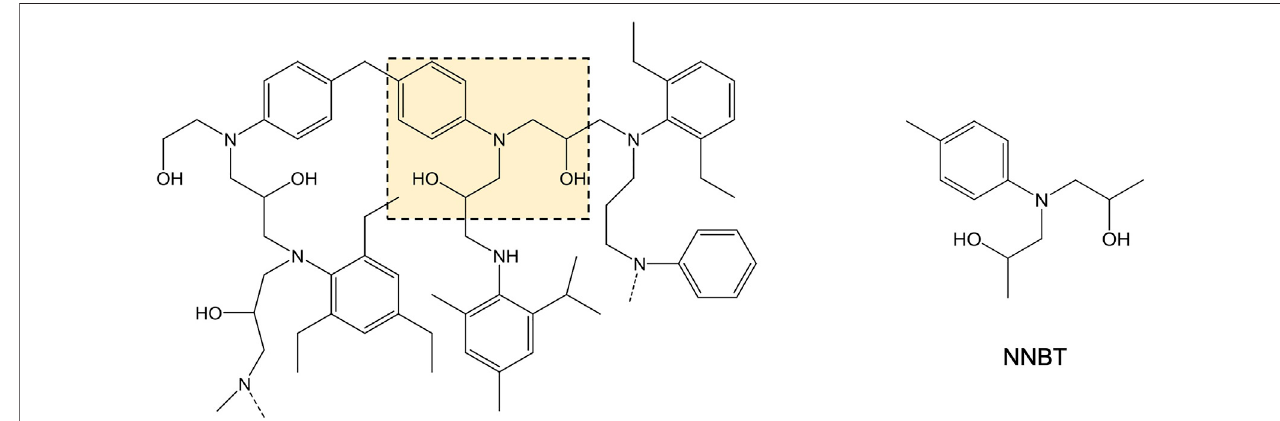
FIGURE 1 | Structural arrangement of Hex fl ow ® RTM6 and the model NNBT scaffold. Left, chemical structure of Hex fl ow ® RTM6 highlighting the main structural motifs in yellow. Right, structure of the model NNBT scaffold.